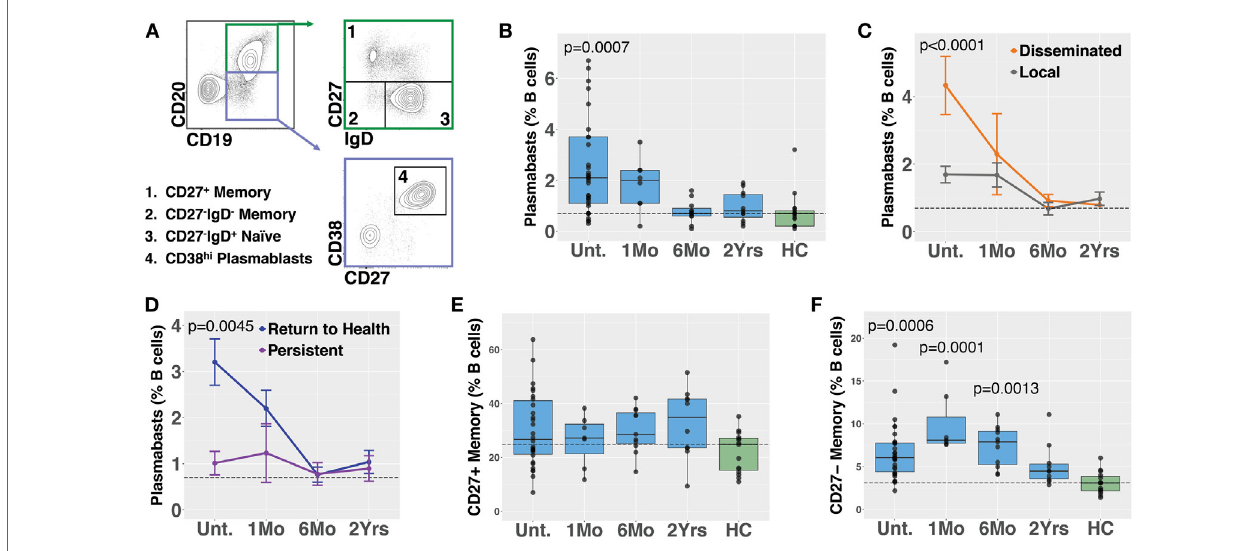
FigUre 1 | Circulating blood plasmablasts and CD27 − memory cells are elevated following Bb infection, and plasmablast numbers differ with patient symptoms. Flow cytometry analysis of peripheral blood mononuclear cells was used to analyze B cell populations in Bb -infected humans at serial time points starting from the initial (untreated) presentation to 2 years following doxycycline treatment. (a) Representative flow cytometry gating of plasmablast and memory B cell populations, starting from CD3 − CD14 − live cells. (B) Plasmablast abundance as a percent of CD19 + B cells. P values shown are versus healthy controls. (c) Patients with disseminated erythema migrans rash have significantly higher plasmablast numbers than those with a single rash. (D) Patients who reported persistent symptoms exhibited lower plasmablasts levels at the initial visit as compared with those that returned to health. (e) Conventional CD27 + memory B cells were not significantly altered following infection, but IgD − CD27 − memory B cells were elevated (F) , peaking at 1 month following completion of doxycycline treatment. P values were determined using ANOVA with Dunnett’s (B,F) or Sidak’s (c,D) multiple comparisons tests. Dashed lines represent the median values of healthy controls, and error bars represent the